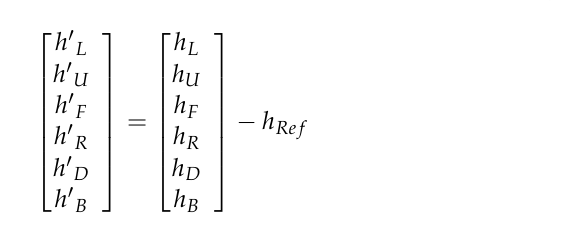
Figure 8. ( a ) Graph over time from 6 + 1 sensors, graph with a bold line calculated from the average of the individual sensors, and ( b ) histogram. Static measurements—sensor array at standstill.